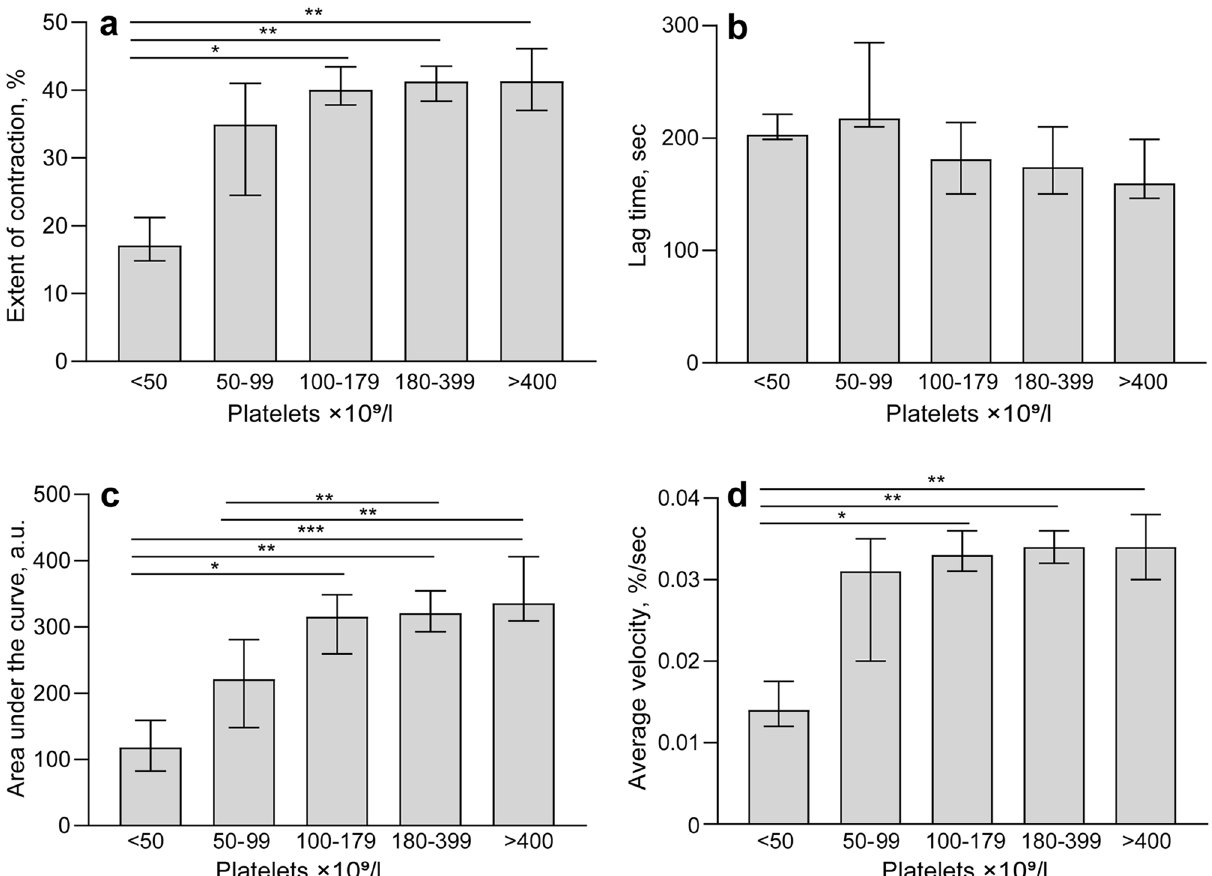
performed by platelets); ( d ) average contraction velocity. The results are presented as median and interquartile range (25th and 75th percentiles). *p < 0.05, **p < 0.01, ***p < 0.001; Kruskal–Wallis test with Tukey’s multiple comparisons post hoc